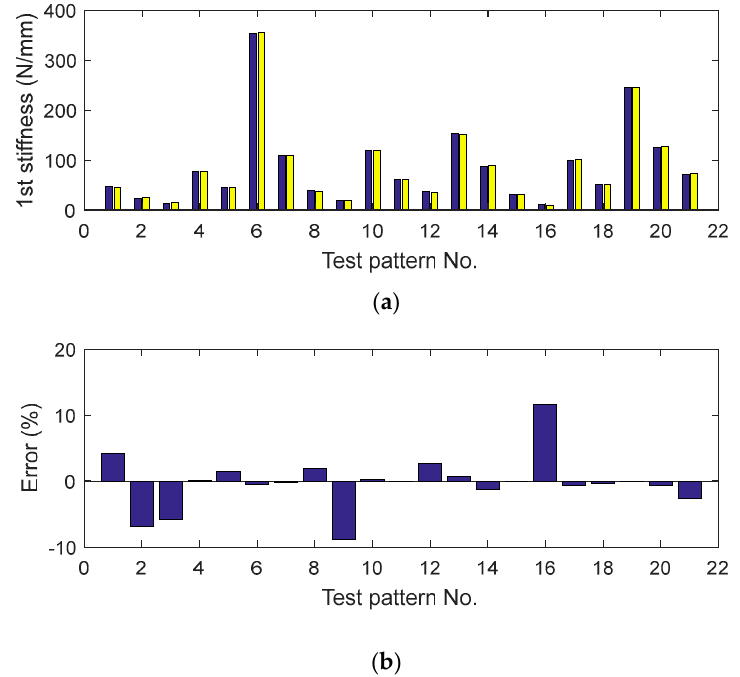
Figure 15. Estimated first stiffness results: ( a ) comparison of first stiffness; ( b ) error.